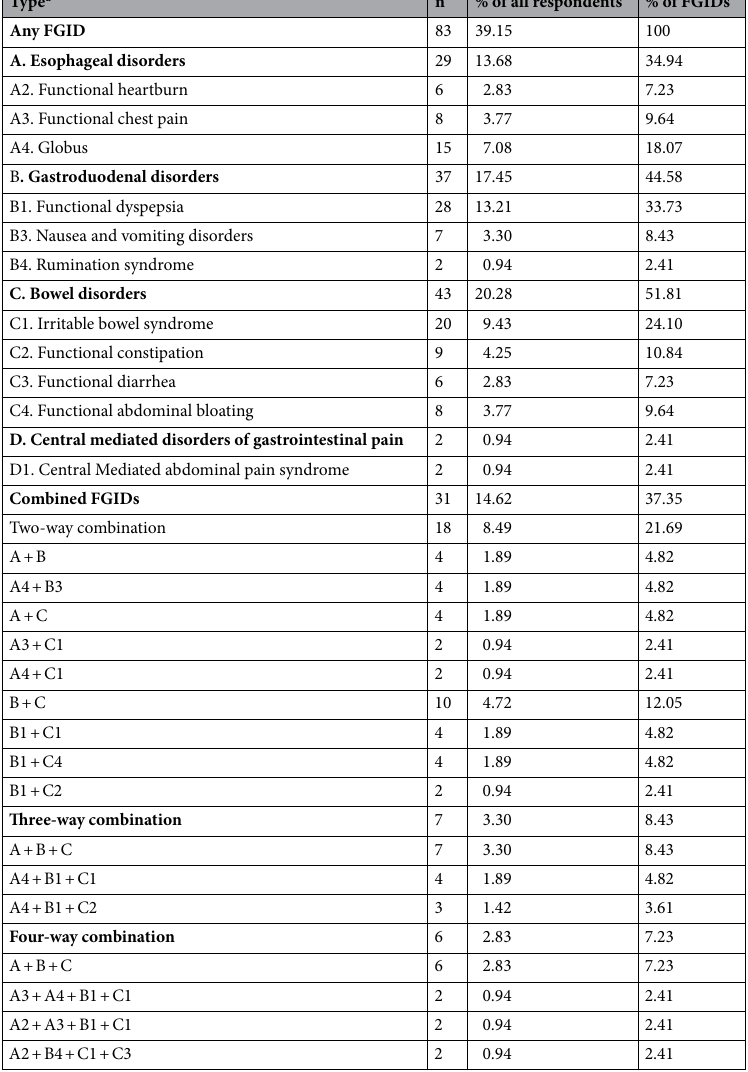
Table 2. Types of functional gastrointestinal disorders with Rome IV diagnostic criteria. a The serial numbers of A–D were coded according to the Rome IV